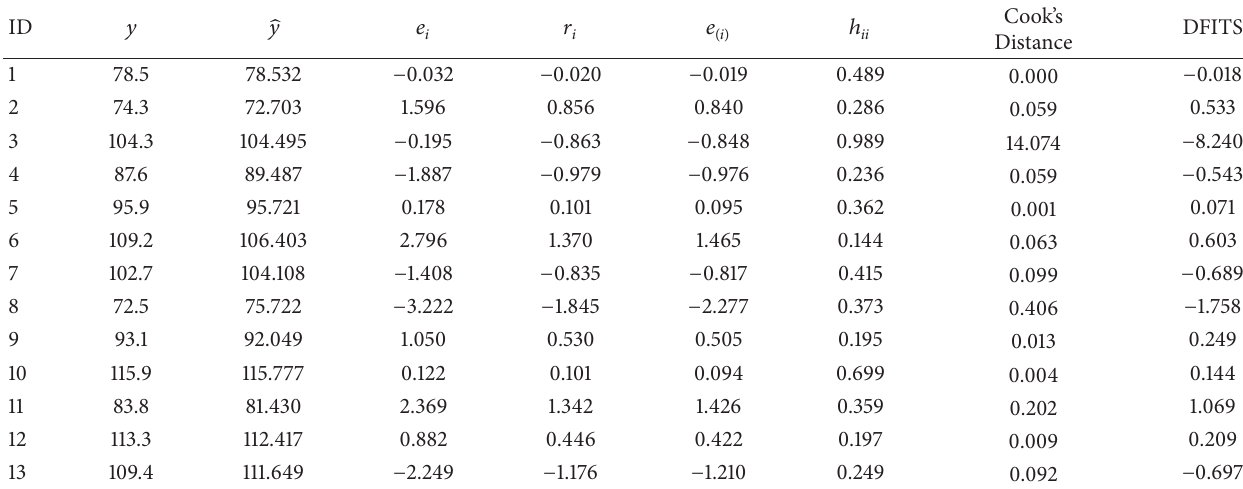
Table 2: Statistics for detecting influential observations for the Hald cement